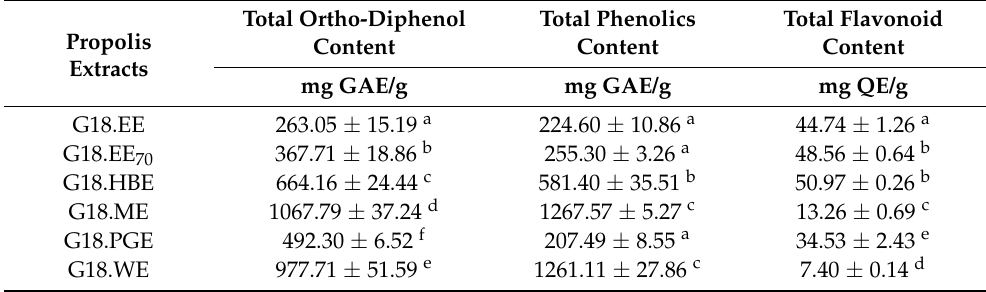
Table 5. Total ortho-diphenols (TOC), phenolics (TPC) and flavonoids (TFC) contents of G18.EE, G18.EE 70 , G18.HBE, G18.ME, G18.PGE and G18.WE. Results are presented as mean ± standard deviation (SD) of mg of gallic acid equivalents per g of extract (mg GAE/g extract) for TOC and TPC, and as mg of quercetin equivalents per g of extract (mg QE/g extract) for TFC. Statistical analysis was performed by one-way ANOVA followed by Tukey’s test for multiple comparisons. For each variable, mean values followed by the same letter (a, b, c, d, e or f) are not statistically